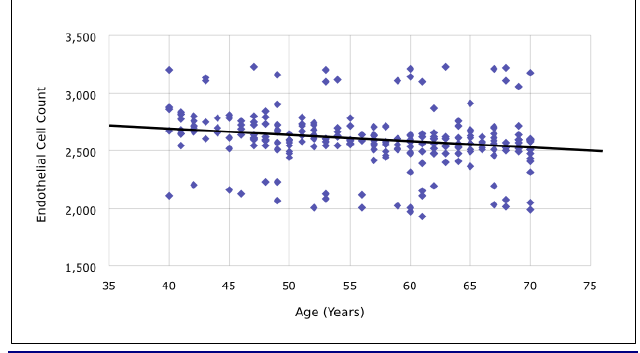
Figure.1: Scatterplot diagram showing correlation between endothelial cell count and age in years Table 3: Distribution according to maternal age with comparison significance.